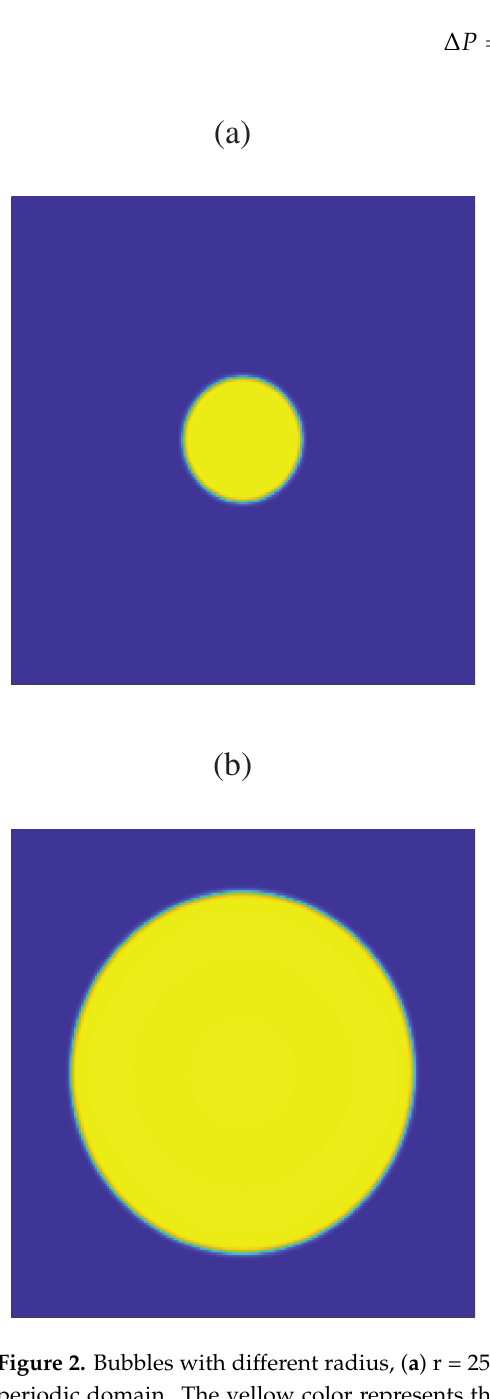
Figure 2. Bubbles with different radius, ( a ) r = 25 δ x and ( b ) r = 75 δ x , in a 100 δ x × 100 δ x × 100 δ x periodic domain. The yellow color represents the lighter fluid, and the blue color represents the denser